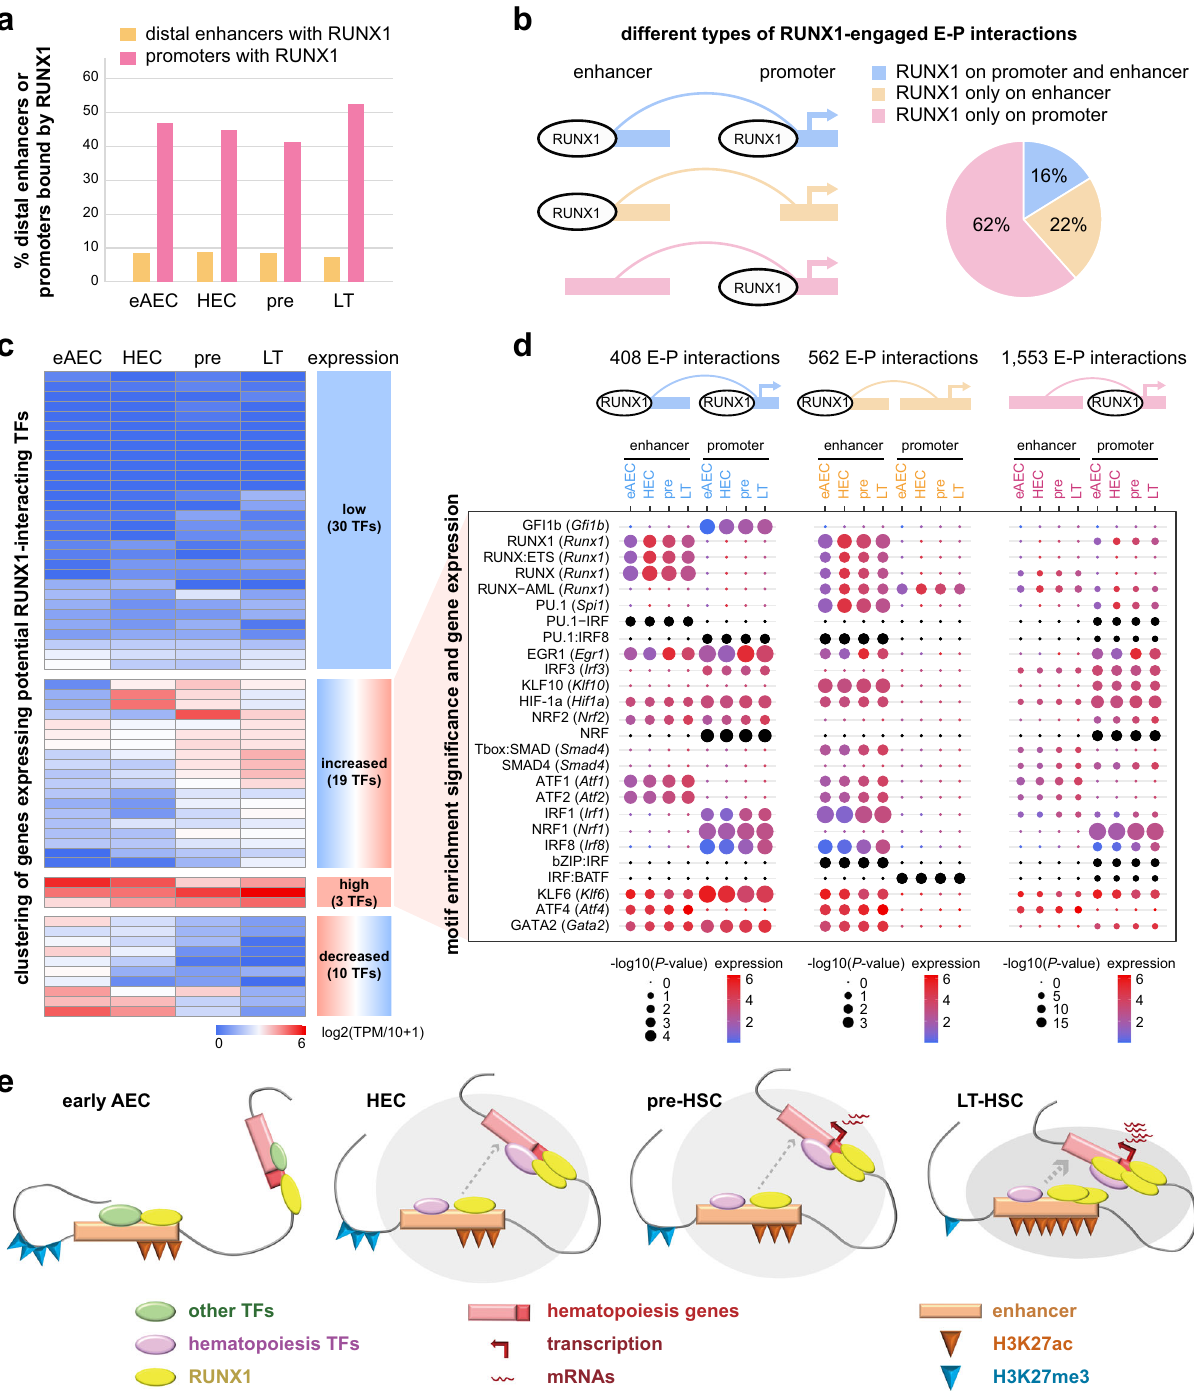
Fig. 5 Identifying potential RUNX1 co-TFs in mediating enhancer – promoter interactions during HSC formation. a Bar plot showing the portion of distal enhancers (with genomic distance to TSS > 5 kb) and promoters (with genomic distance to TSS ≤ 5 kb) within RUNX1-engaged E – P interactions. b Pie chart showing the portion of E – P interactions with RUNX1 occupancy on promoters, enhancers, or both. Schematic on the left shows the three types of genomic locations of RUNX1 occupancy. c Hierarchical clustering based on gene expression of potential RUNX1-interacting TFs identi fi ed through de novo TF motif discovery on the E – P looping regions as above. TF genes used for clustering were genes in families whose protein binding motifs were top 11 signi fi cant in all candidates identi fi ed in Supplementary Fig. 7b. Gene expressions were calculated by log2(TPM/10 + 1) from scRNA-seq data. d Bubble plots showing signi fi cances of TF motif enrichments as in ( c ), together with gene expression. TF motif analysis was performed by HOMER. P -value was calculated by two-sided binomial test. e Working model of multi-omics dynamics during HSC formation. RUNX1 occupies target promoters or/and enhancers primed with H3K27ac in eAECs. Repressive H3K27me3 gradually diminishes accompanying later H3K27ac increase. Other hematopoiesis related TFs are recruited to form a TF module with RUNX1 to facilitate enhancer – promoter interactions driving the core HSC gene expression. eAEC early AEC, pre pre-HSC, LT LT-HSC.